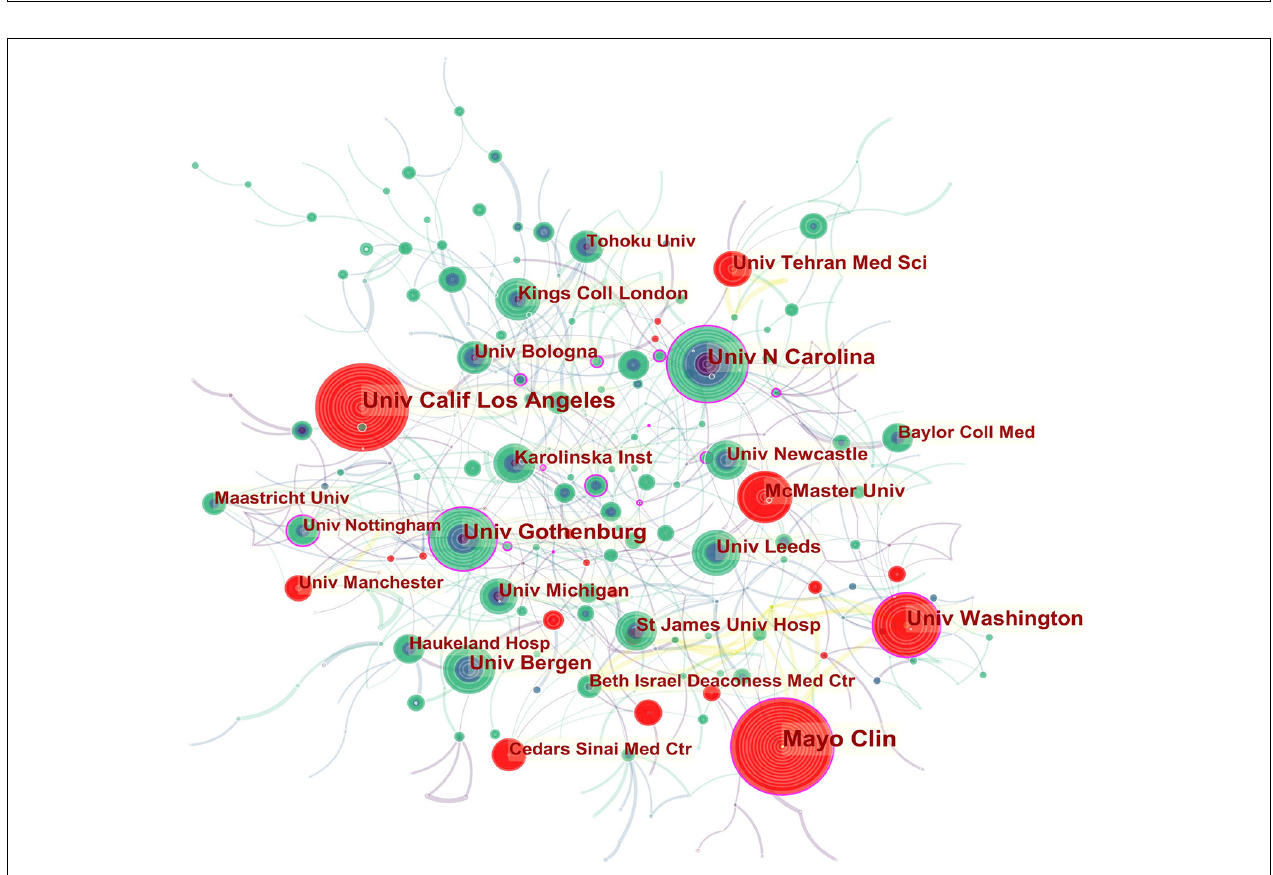
FIGURE 3 | Network of institutions engaged in IBS